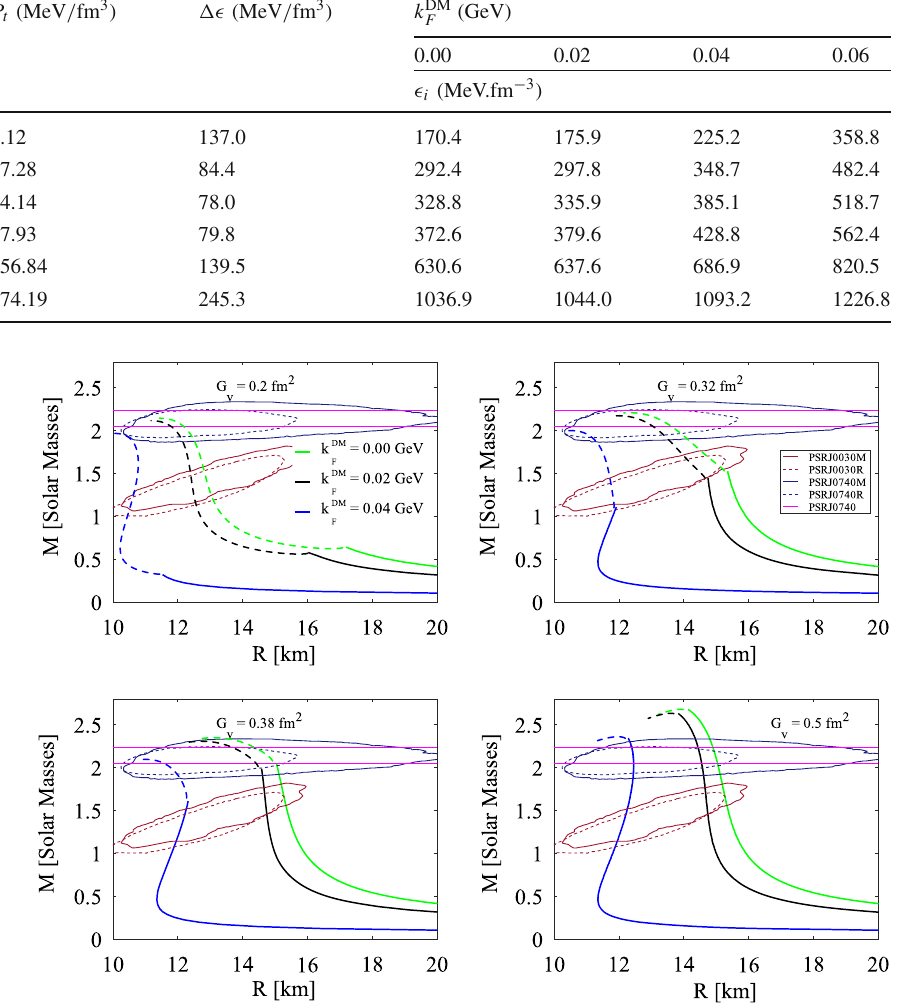
Table 1 Chemical potential (μ t ), pressure ( P t ), energy density gap ((cid:15)(cid:14)) and initial value where the phase transition begins, (cid:14) the transition for different coupling constants of the vector MIT bag